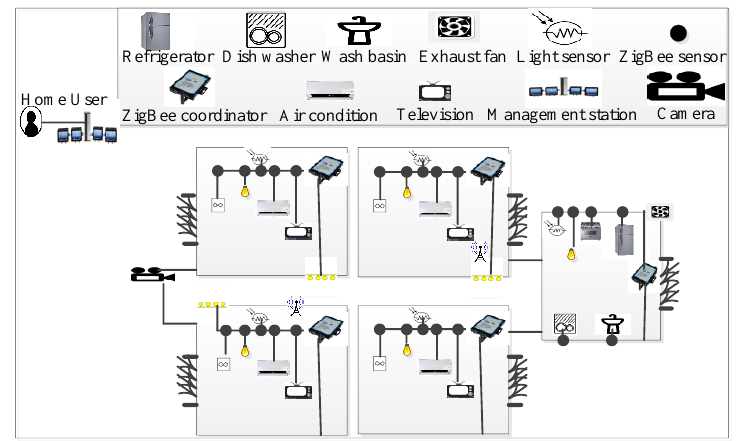
Figure 2. Smart home control system.